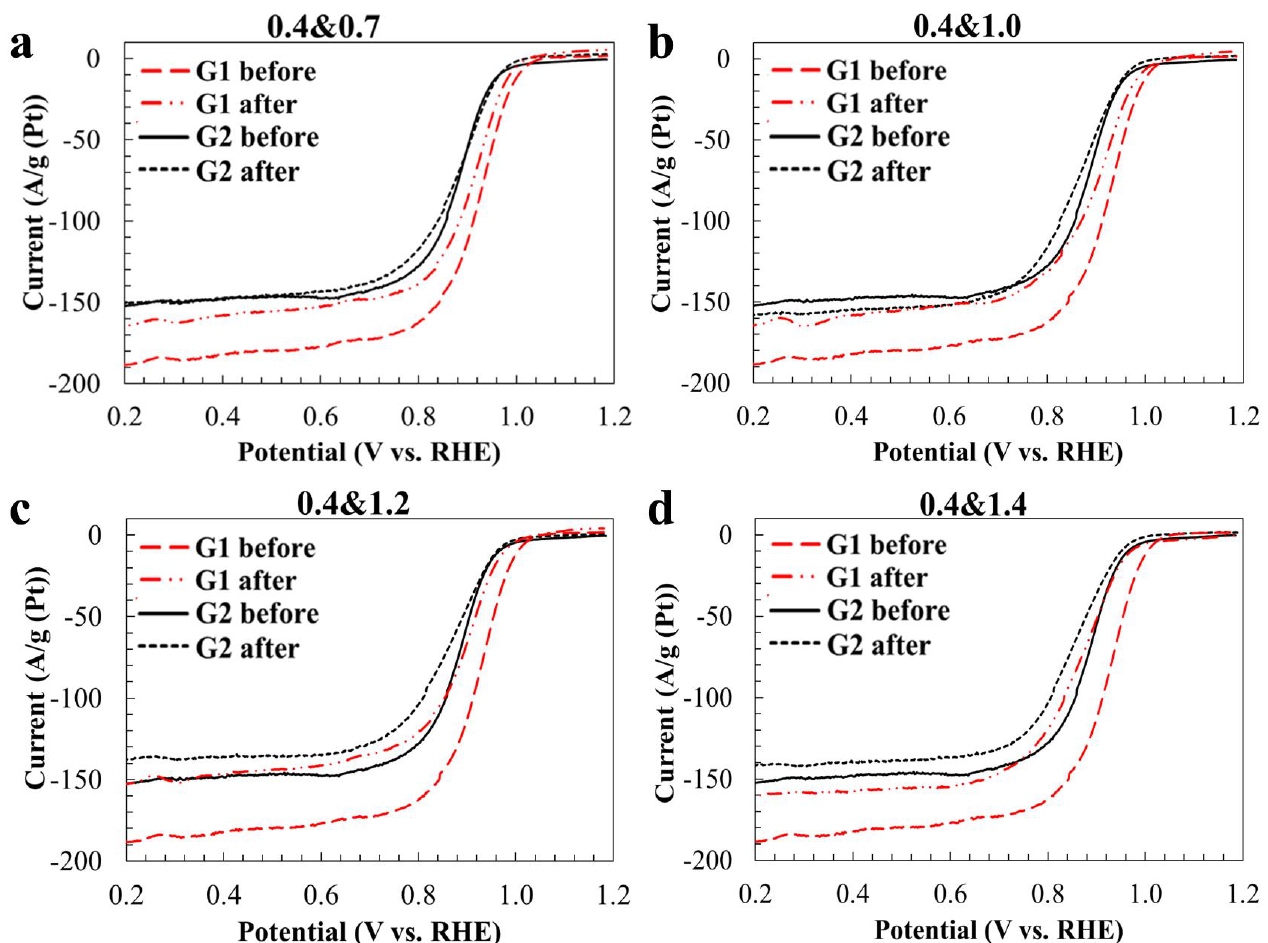
Figure 8. LSV curves for ORR of Pt/C before and after different ADT protocols: ( а ) 0.4 and 0.7 V; ( b ) 0.4 and 1.0 V; ( c ) 0.4 and 1.2 V; and ( d ) 0.4 and 1.4 V, 1600 rpm, O 2 − atmosphere. The potential scan rate is 20 mVs − 1 , the electrolyte is 0.1 М HClO 4 , and Т = 60 ° С. Table 2. Characteristics of Pt/C catalysts after ADT in different potential ranges.